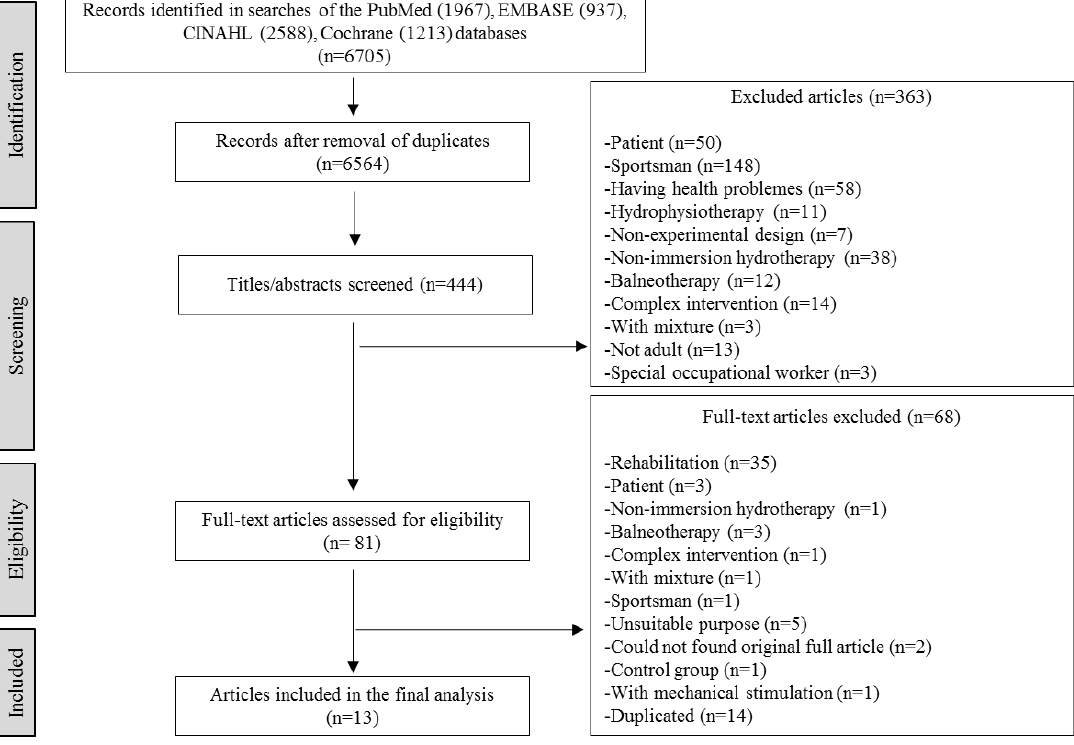
Figure 1. Flowchart for processing.